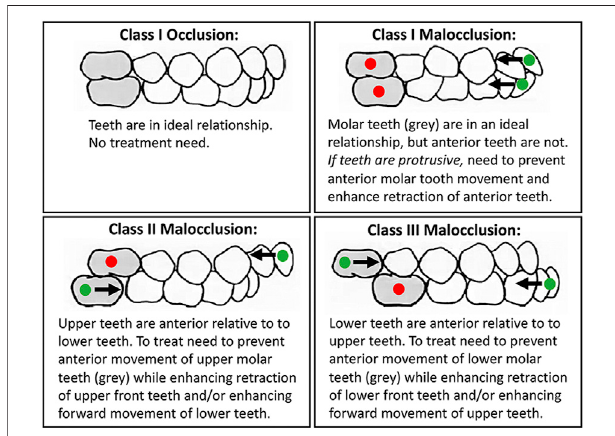
FIGURE 1 | Many malocclusions require differential orthodontic tooth movement to achieve ideal functionaland esthetic outcomes. Teeth that need inhibition of movement for successful treatment are marked with a red dot. Teeth thatneedenhancementofmovementforsuccessfultreatment are marked with a green dot. Arrows mark direction of desired tooth